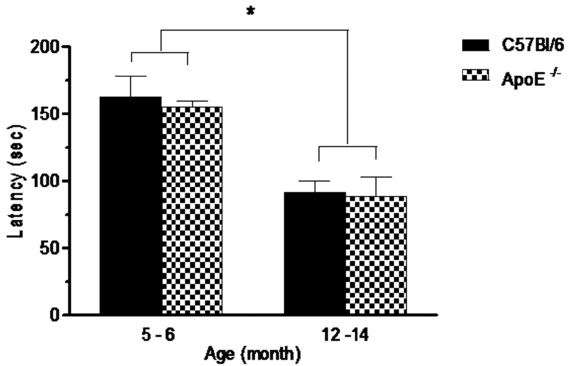
Figure 2. Performances in the rotarod test, expressed as latency to fall off a rotating rod (s) is significantly reduced in aged mice (12 to 14 months) in comparison with younger mice (5 to 6 month). No differences were seen between strains or sexes (n=10/sex/age/genotype). Values are expressed as combined male and female data means ± SEM. * Groups with statistically signi fi cant differences (F(3/54) = 14.17, p = 0.000). Kruskal Wallis non-parametric one-way ANOVA and Tukey’s Multiple Comparison Tests.